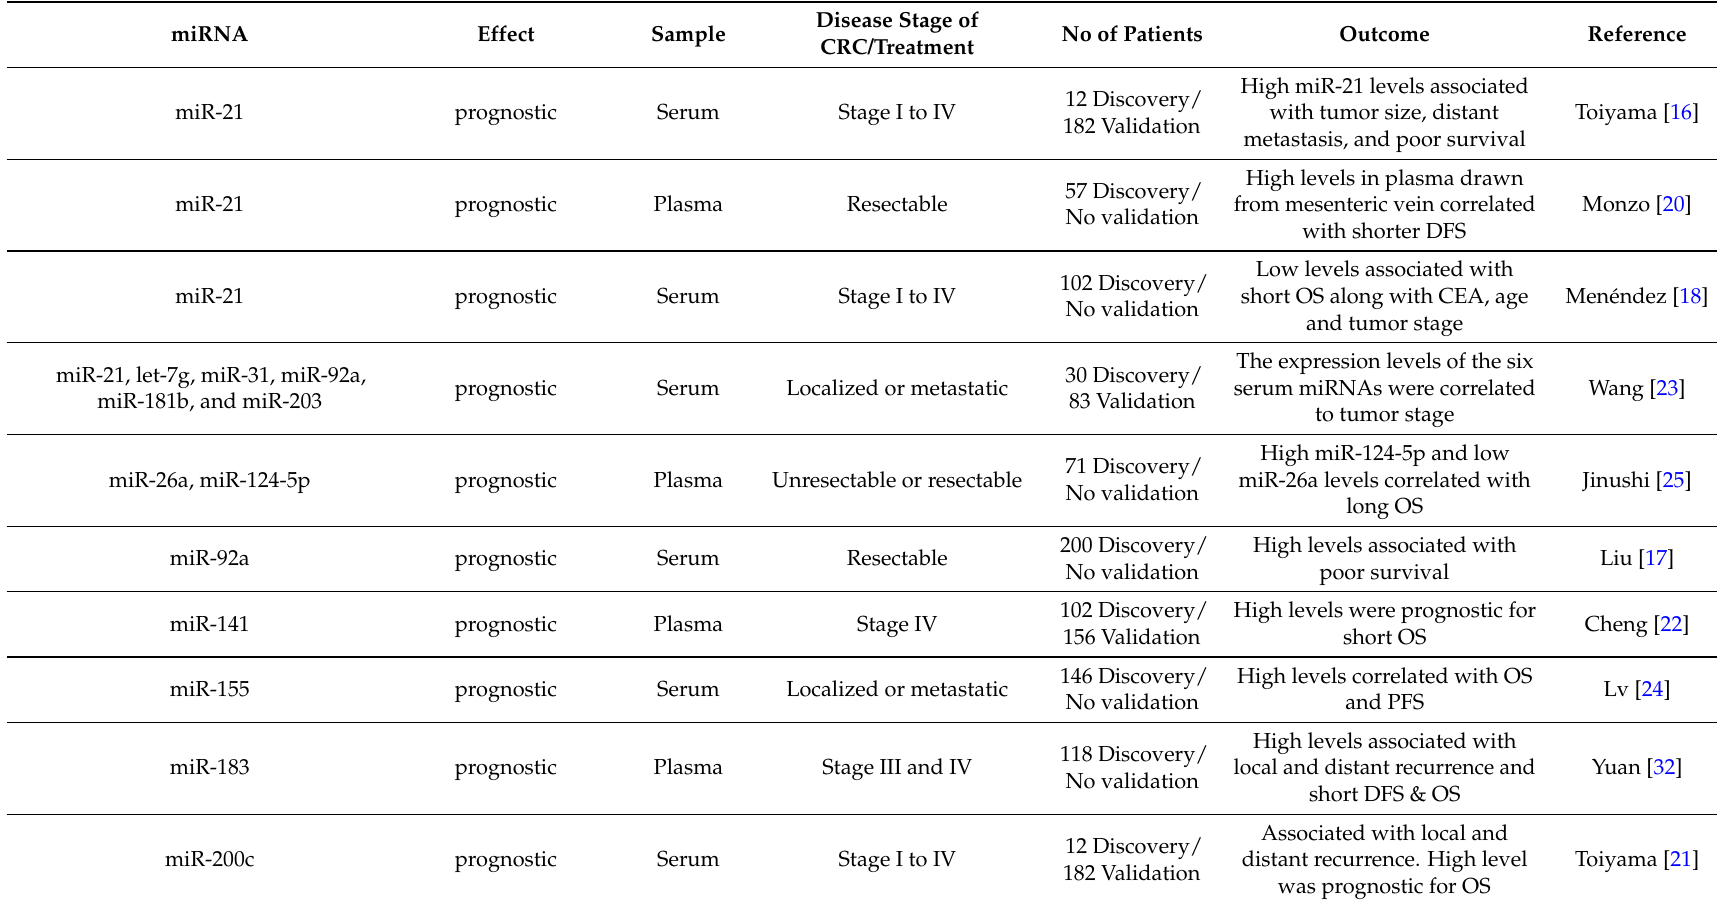
Table 1. Summary of circulating miRNAs as prognostic or/and predictive biomarkers in patients with colorectal